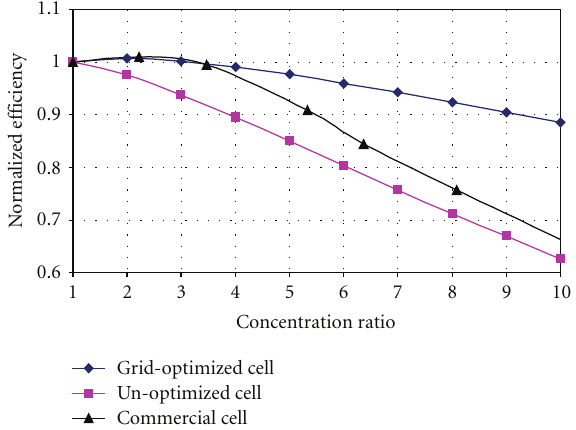
Figure 4: Normalized plot of E ffi ciency against the concentration ratio of the optimized and unoptimized grid solar